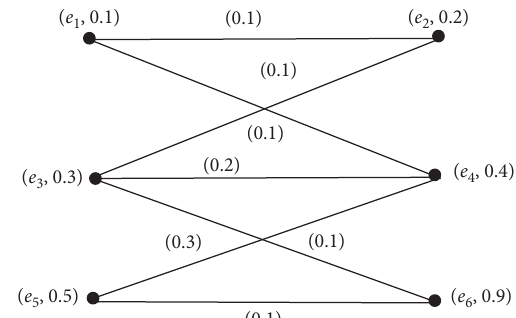
Figure 5: Fuzzy graph G � ( J , K )